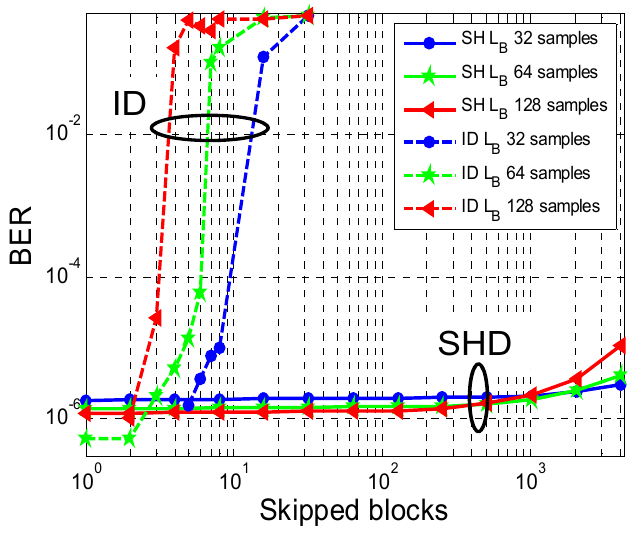
Figure 4. Averaged BER as a function of the carrier phase (CP) estimation rate for estimation block sizes of 32, 64 and 128 samples and aligned pilot-tone (PT) and signal paths (solid lines) and misaligned PT and signal paths (dashed